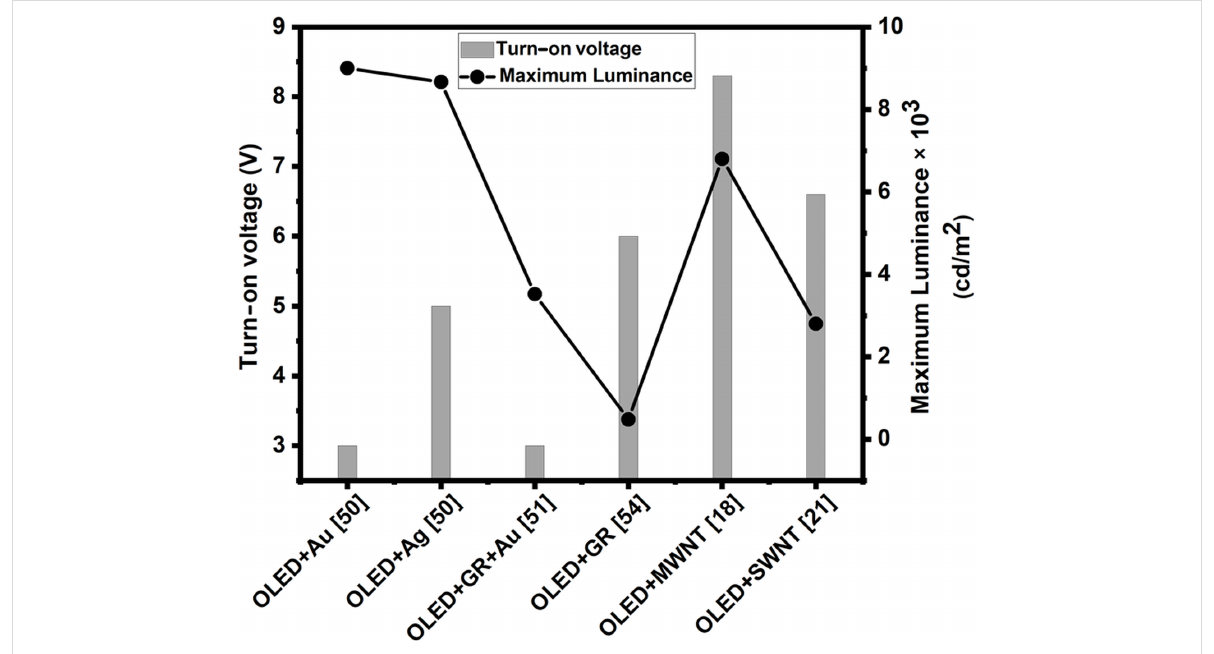
Figure 5: Comparison of turn-on voltage and maximum luminance of OLED with AgNP, AuNP, graphene, MWNT, and SWNT in the device structure.